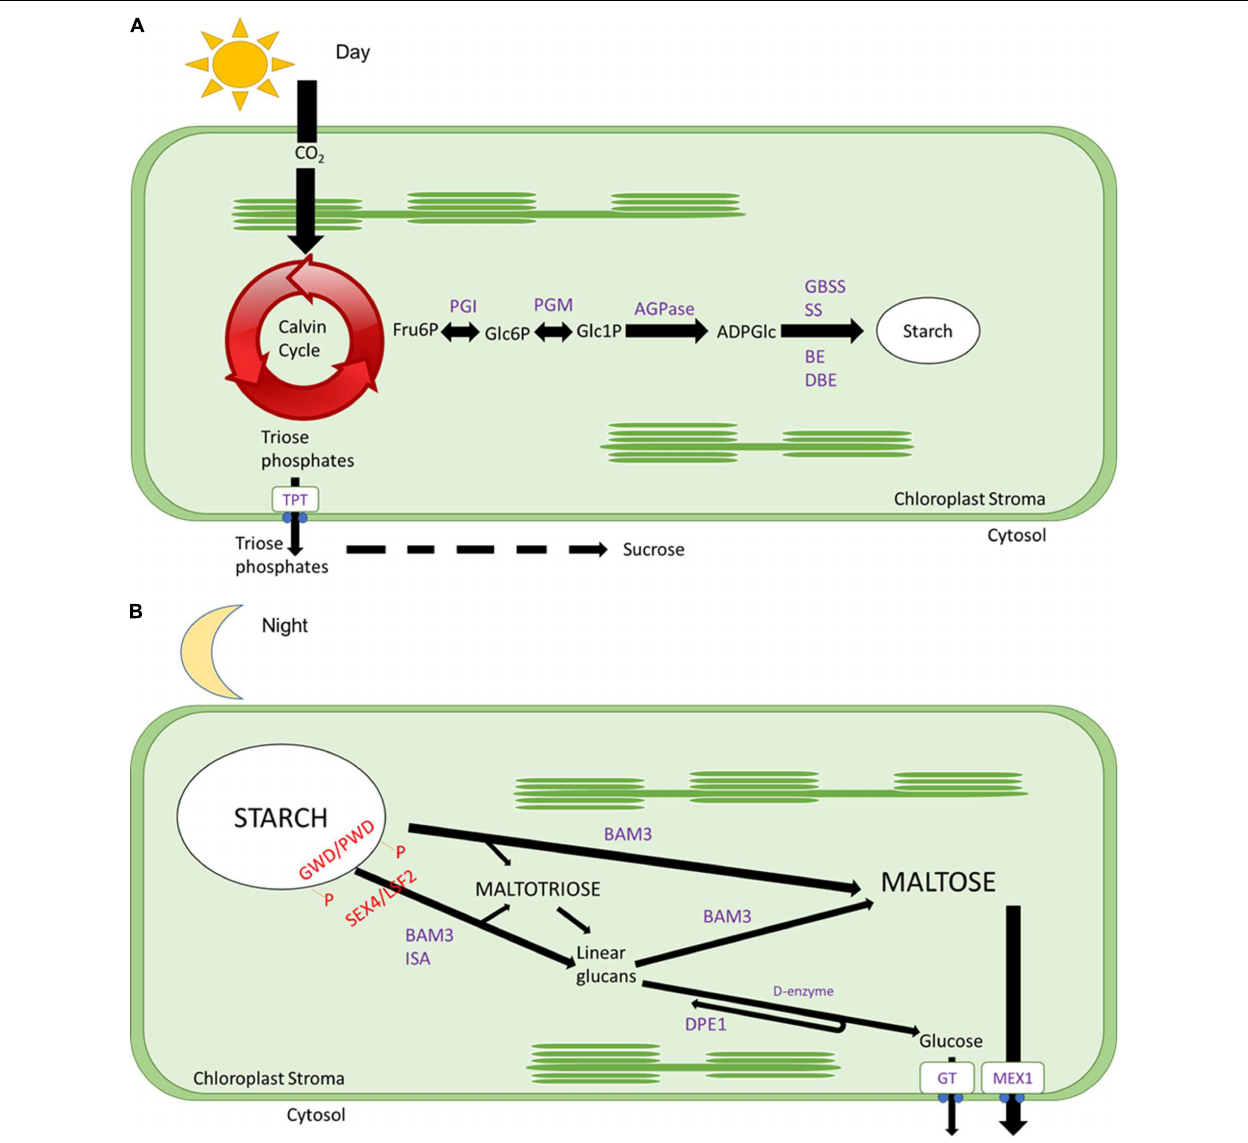
FIGURE 1 | Daily starch metabolism. (A) During the day, CO 2 is fixed by the Calvin cycle, and trioses phosphates will be exported out of the chloroplast to the cytosol through a triose phosphate transporter protein to be converted into sucrose. While fructose 6-phosphate will be converted into glucose 6-phosphate by phosphoglucose isomerase (PGI), then converted to glucose 1-phosphate by phosphoglucomutase (PGM), later converted to ADP glucose by ADP glucose pyrophosphorylase (AGPase), after polymerised by starch synthases (SS) and granule bound starch synthases (GBSS) and branched by branching enzymes (BE) and debranching enzymes (DBE). (B) During the night, the surface of the starch granule is loosed by glucan phosphorylation catalysed by glucan water dikinases (GWD), and phosphoglucan water dikinases (PDW) followed by the action of β -amylases (BAMs, especially BAM3 with a subsidiary role for BAM1, see Smith and Zeeman, 2020) and isoamylase 3 (ISA3). Starch breakdown results in the formation of maltose and maltotriose. Maltotriose is converted by disproportionation enzyme 1 (DPE1) to glucose and longer glucans that can be degraded to maltose by β -amylases. The action of BAM3, ISA3, and PDE1 requires removal of phosphate by the glucan phosphatases starch excess 4 (SEX4) and Like Sex Four 2 (LSF2). Glucose is exported to the cytosol by glucose transporter (GT), and maltose is exported out by a maltose exporter 1 (MEX) to be utilised as an energy source for nighttime reactions.